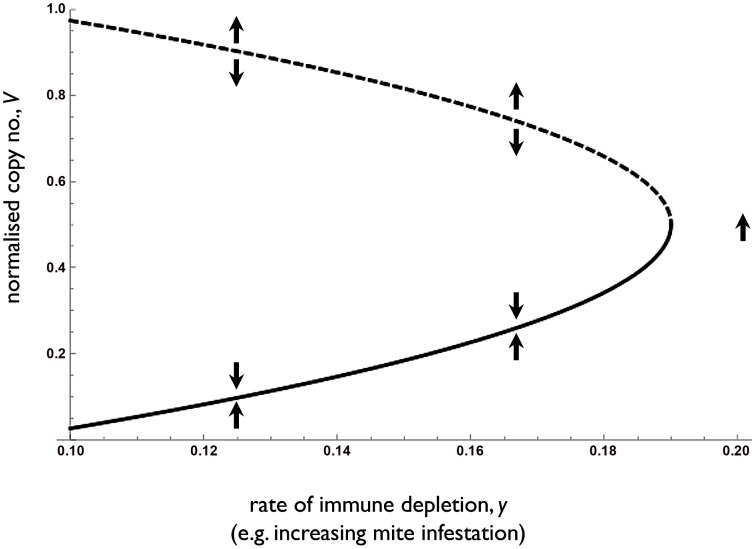
Accelerating or ‘threshold’ immuno-suppression by DWV can create bistable DWV dynamics.The stable (solid line) and unstable (dotted line) equilibrium level of DWV (arbitrary scale) are calculated from equations S4, S5, and plotted as a function of increasing levels of immune depletion (y). Below the dotted line, the virus can be efficiently regulated by the immune-system to some intermediate (potentially cryptic) density, represented by the solid line. Above the dotted line (and for high y, any point to right of intersection with solid line), the virus cannot be efficiently regulated and a viral explosion ensues. Any factor such as mite feeding that depletes the immune system (increasing y) will first cause a gradual increase in copy number, V (moving right along the solid line), and then at a defined point (intersection of solid and dotted lines), a viral explosion will ensue. Parameters are x = 0.09 (y>x ensures that the virus can invade from rare) and z = 0.4.